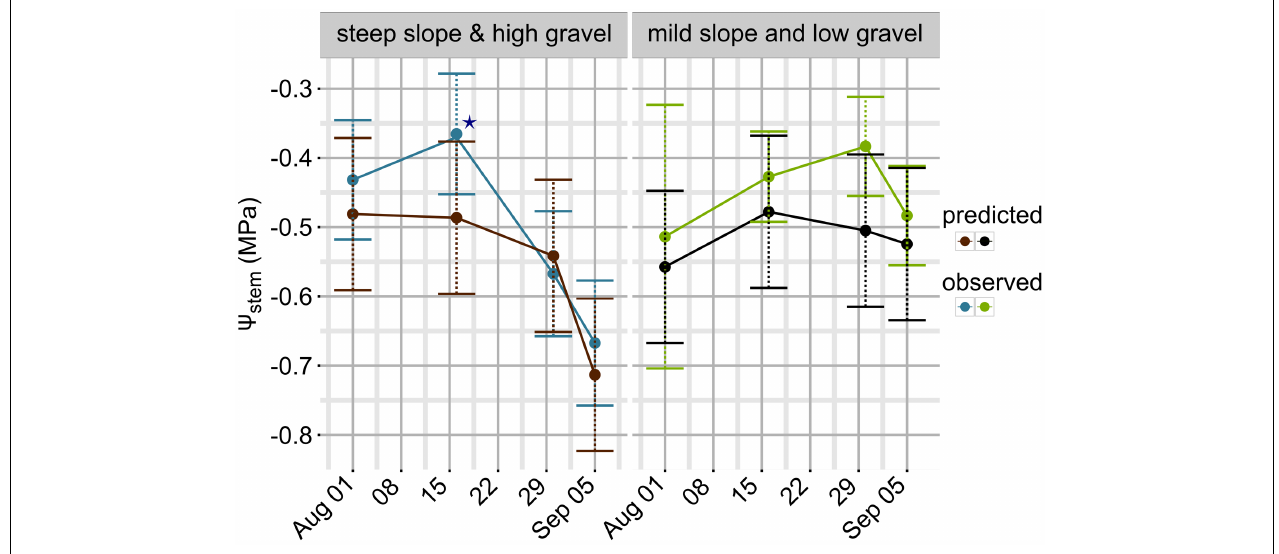
FIGURE 5 | Observed and predicted (cid:57) stem trends in 2011 (test-set and different meteorological data). Error bars are mapped to standard deviation for observed data points (blue: steep slope and high gravel content; green: mild slope and low gravel content). For predicted values, error bars are equal to 0.11 MPa, i.e., the RMSE evaluated on the test-set. (cid:70) indicates missing data for plot A and B on 2011-08-16 (both steep slope and high gravel content, Table 1 ); missing data were replaced by the mean of the whole dataset for this